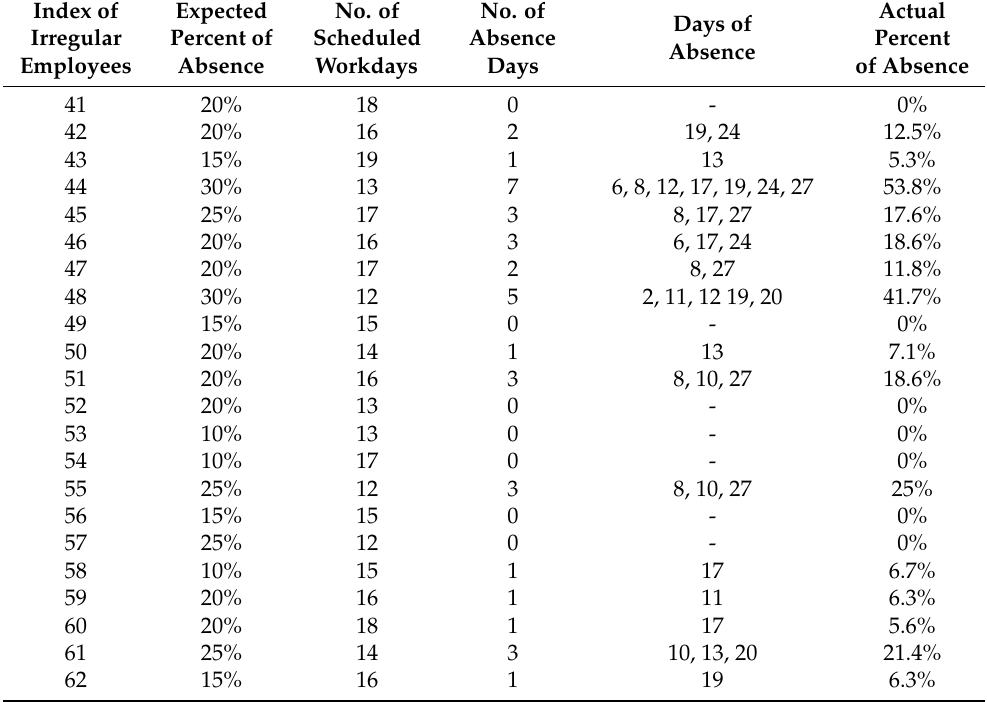
Table 6. Information on each irregular employee’s work and